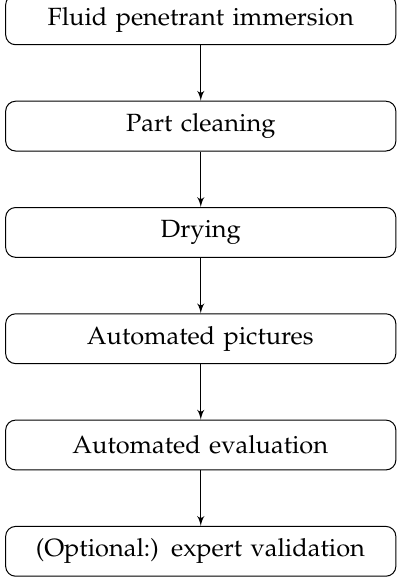
Figure 2. FPI automation